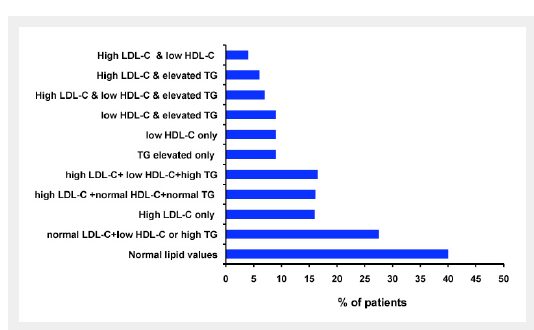
Figure 2 Abnormalities of the lipid profile found in the 473 patients included in the final analysis. LDL-C: low density lipoprotein-cholesterol, TG: triglycerides, HDL- C: high density lipoprotein-cholesterol. High LDL-C was defined as LDL-C >2.6 mmol/L high risk patients, LDL-C ≥4.1 mmol/L in patients with low cardiovascular risk; low HDL-C was defined as HDL-C <1.3 mmol/L in women or <1 mmol/L in men; high TG were defined as TG ≥1.7 mmol/L in high risk patients and ≥5.0 mmol/L in patients with low or intermediate risk.